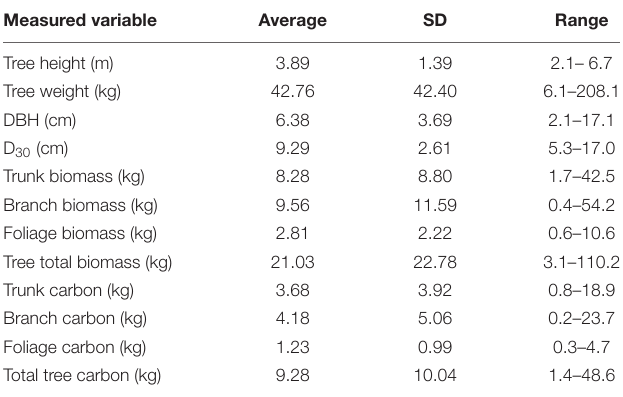
TABLE 1 | Summary statistics for physical measurement data collected from the 20 harvested trees used in this study. Measured